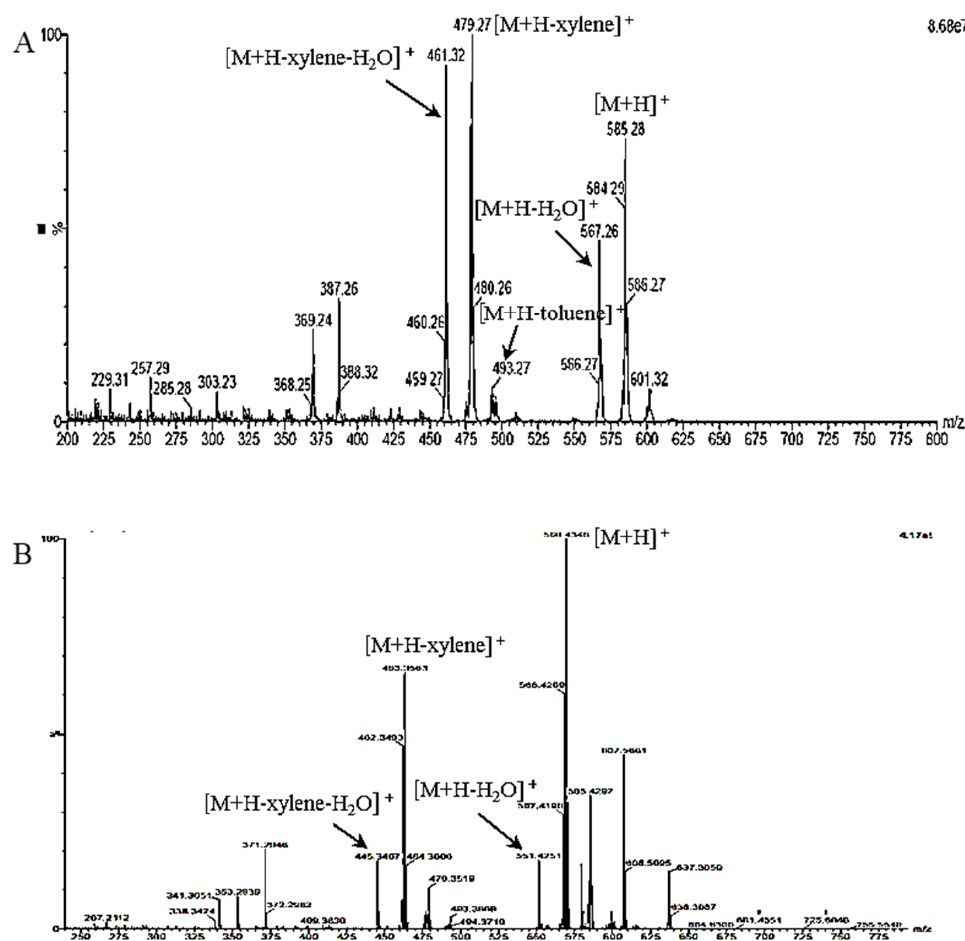
Figure 3. Mass spectra of C-1 ( A ) and R-1 ( B ) isolated from saponified extract of ripe MT fruits. ( A ) positive APCI-MS spectrum; ( B ) positive APCI-Q-TOF-MS/MS Table 1. NMR spectral data for compounds C-1 and R-1 a.